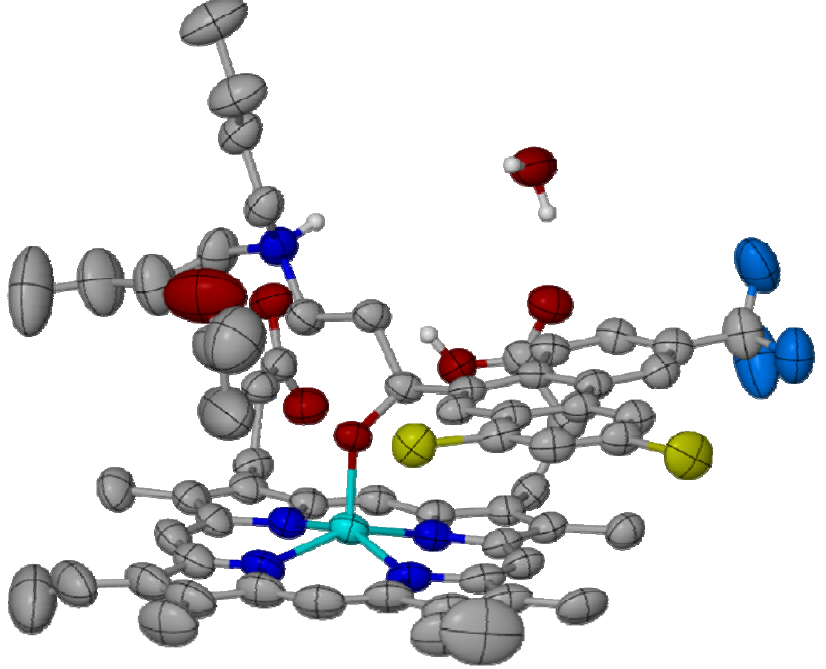
Figure 5. The crystal structure of the Fe(III)PPIX-halofantrine complex. Thermal ellipses are drawn at 50% probability, illustrating significant disorder in the Fe(III)PPIX vinyl groups, butyl chain termini of halofantrine and the included acetone molecule. Atom colouring: C: grey, Cl: yellow; F: Prussian blue, Fe: cyan, H: white, N: blue, O: red. Reprinted with permission from reference [63]. Copyright 2008